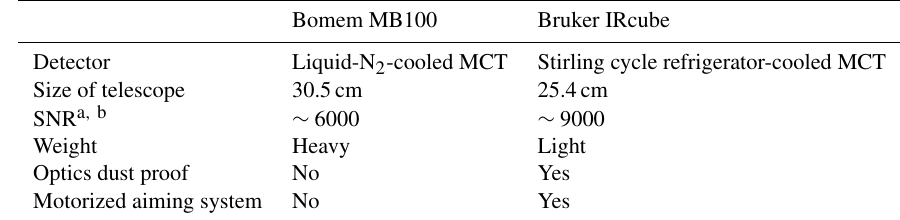
Table 3. The system parameters between OP-FTIR Bomem MB100 and Bruker IR cube spectrometers. Bomem MB100 Bruker IRcube Stirling cycle refrigerator-cooled MCT